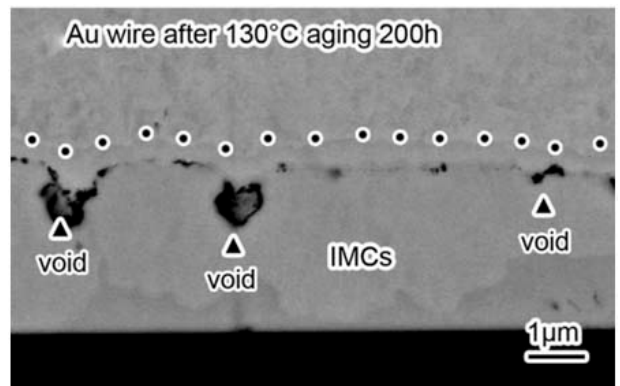
Figure 3. The cross-section images of bonding interface of Au wire after aging at 130 ◦ C for 200 h [44]. Copyright, 2020, Springer